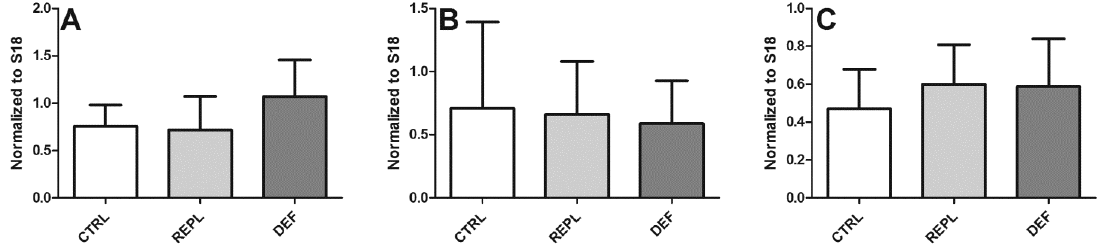
Figure 1. Quantitative PCR analysis of SVCT2 mRNA expression in brain. Quantitative PCR analysis of SVCT2 from three brain regions of guinea pigs between CTRL, REPL and DEF groups; Expressed values are mean of normalized ratio of SVCT2 to the reference gene S18 ± SD; target gene expression in HP ( A ); BC ( B ); and BFC ( C ), n = 10 for each group. Effect of diet between the three groups was assessed by one way ANOVA ( p > 0.05).